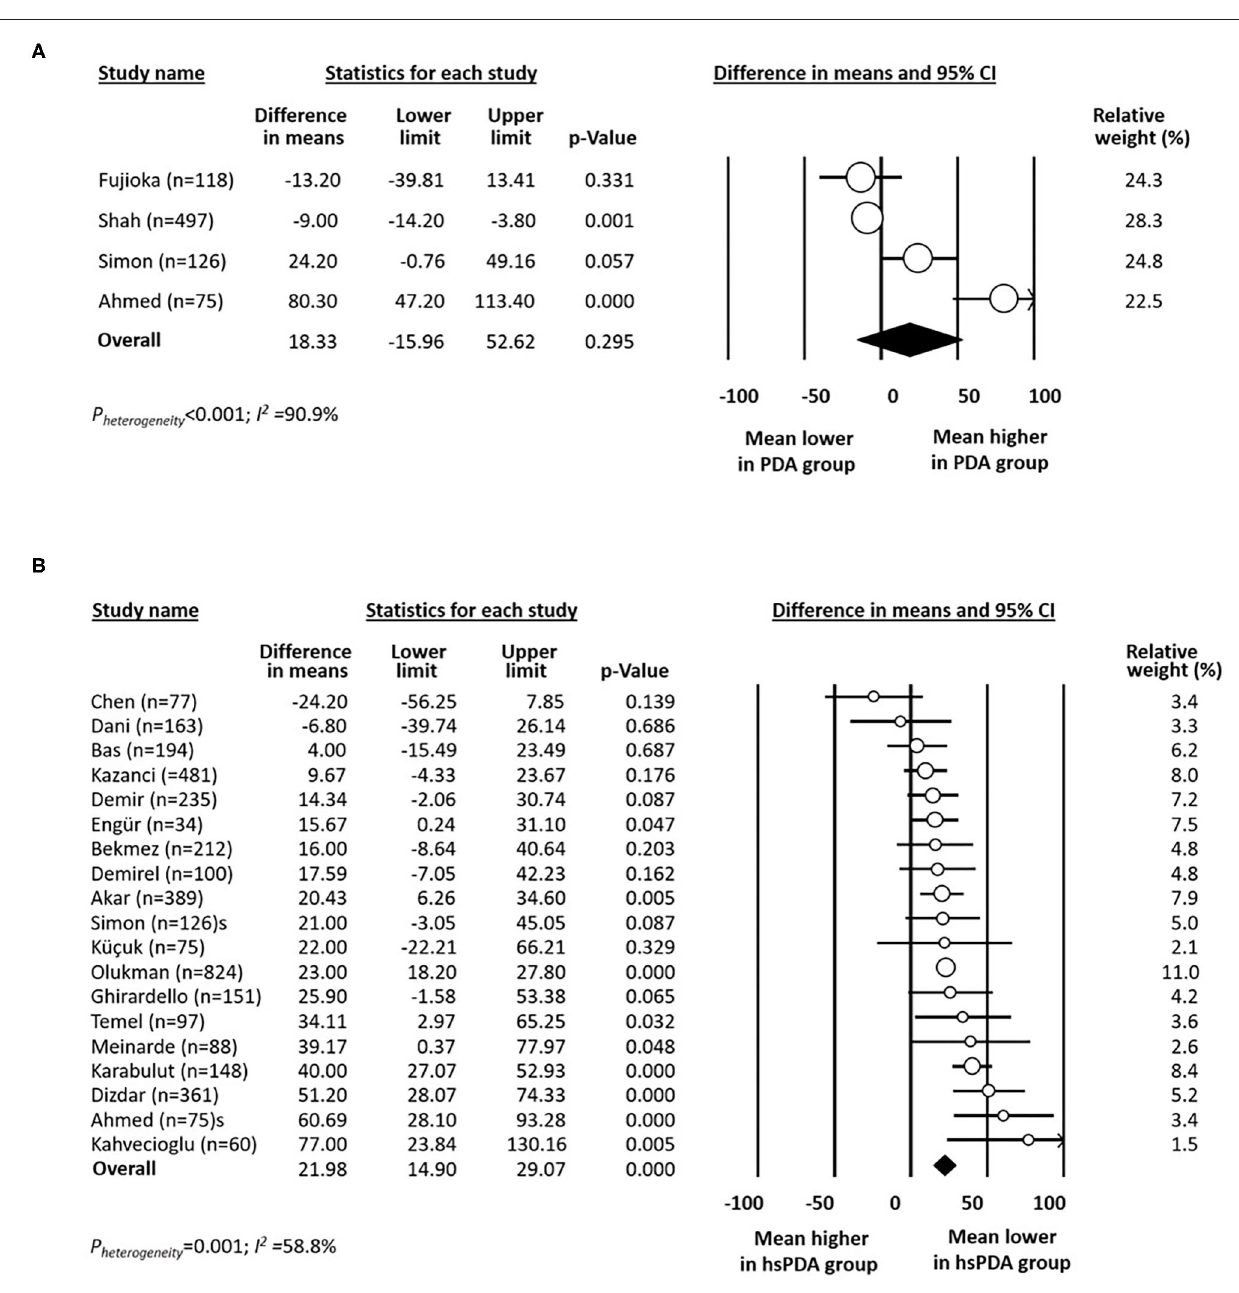
Frontiers in Pediatrics |